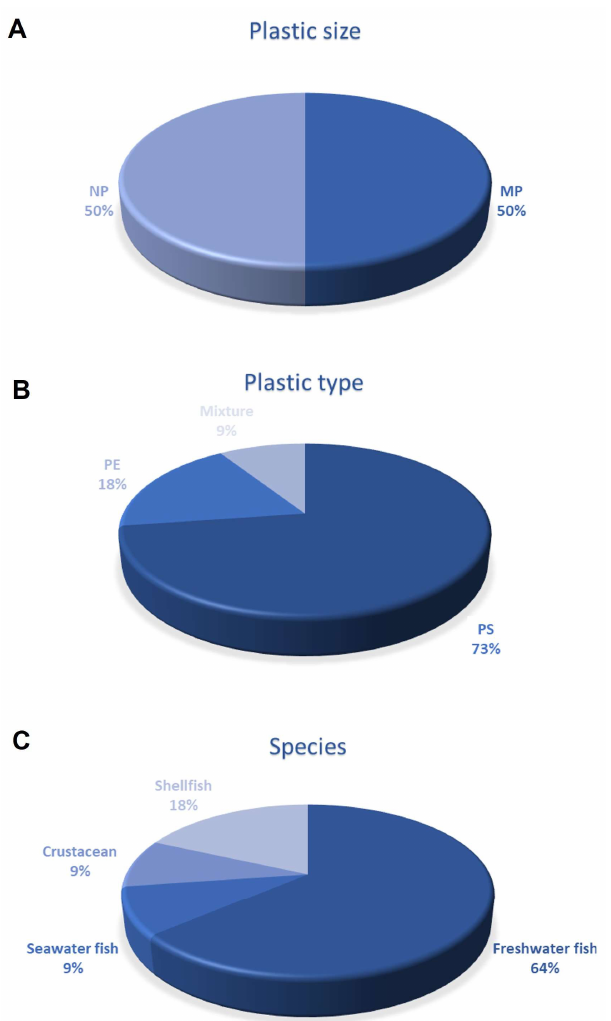
Figure 3. Charts summarising the studies on aquatic fauna included in the present review. Panel ( A ) reports plastic size, either MPs or NPs used in the studies. In ( B ), plastic types. In ( C ), aquatic species considered for the investigation of MPs-NPs effects.